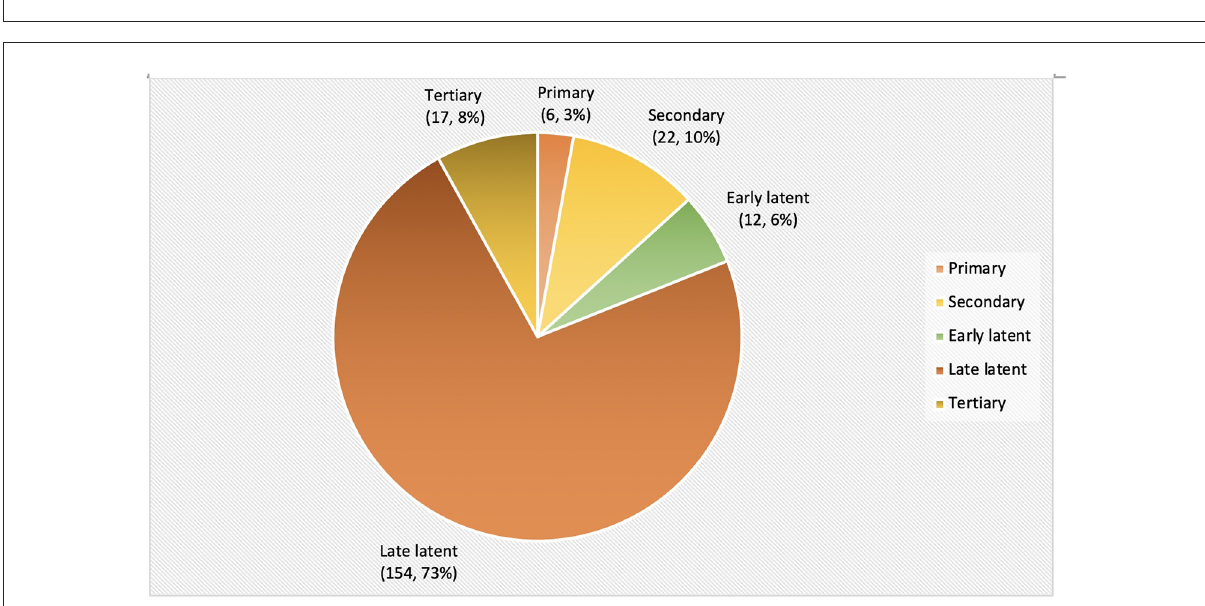
FIGURE2 The stage of syphilis at